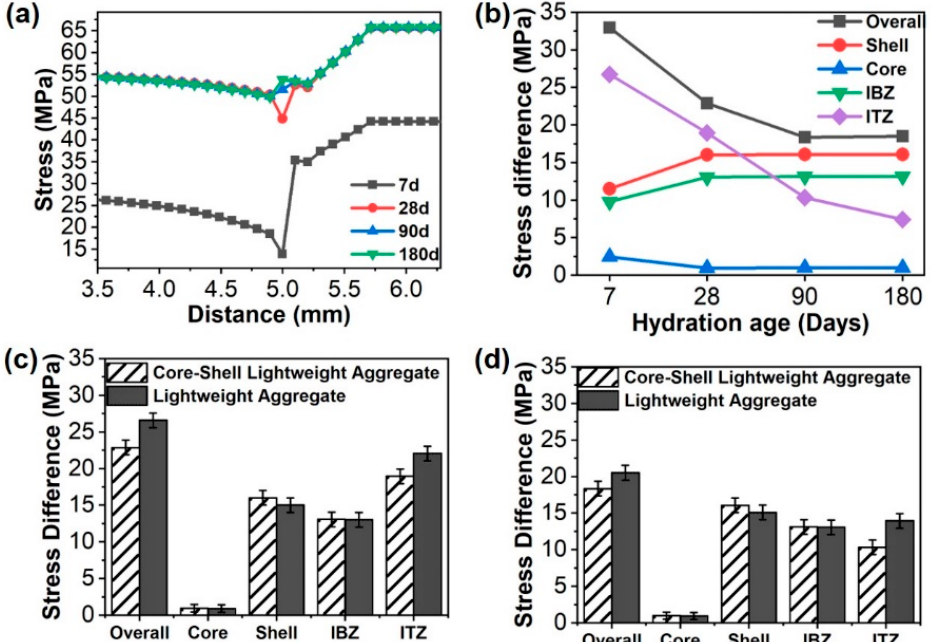
Figure 7. ( a ) Path I path stress distribution curve for different ages; ( b ) Average stress of the core, shell, and the entire model of different ages; ( c ) Stress difference of each part of the model at hydration age of 28 days; and ( d ) Stress difference of each part of the model at hydration age of 90 days.